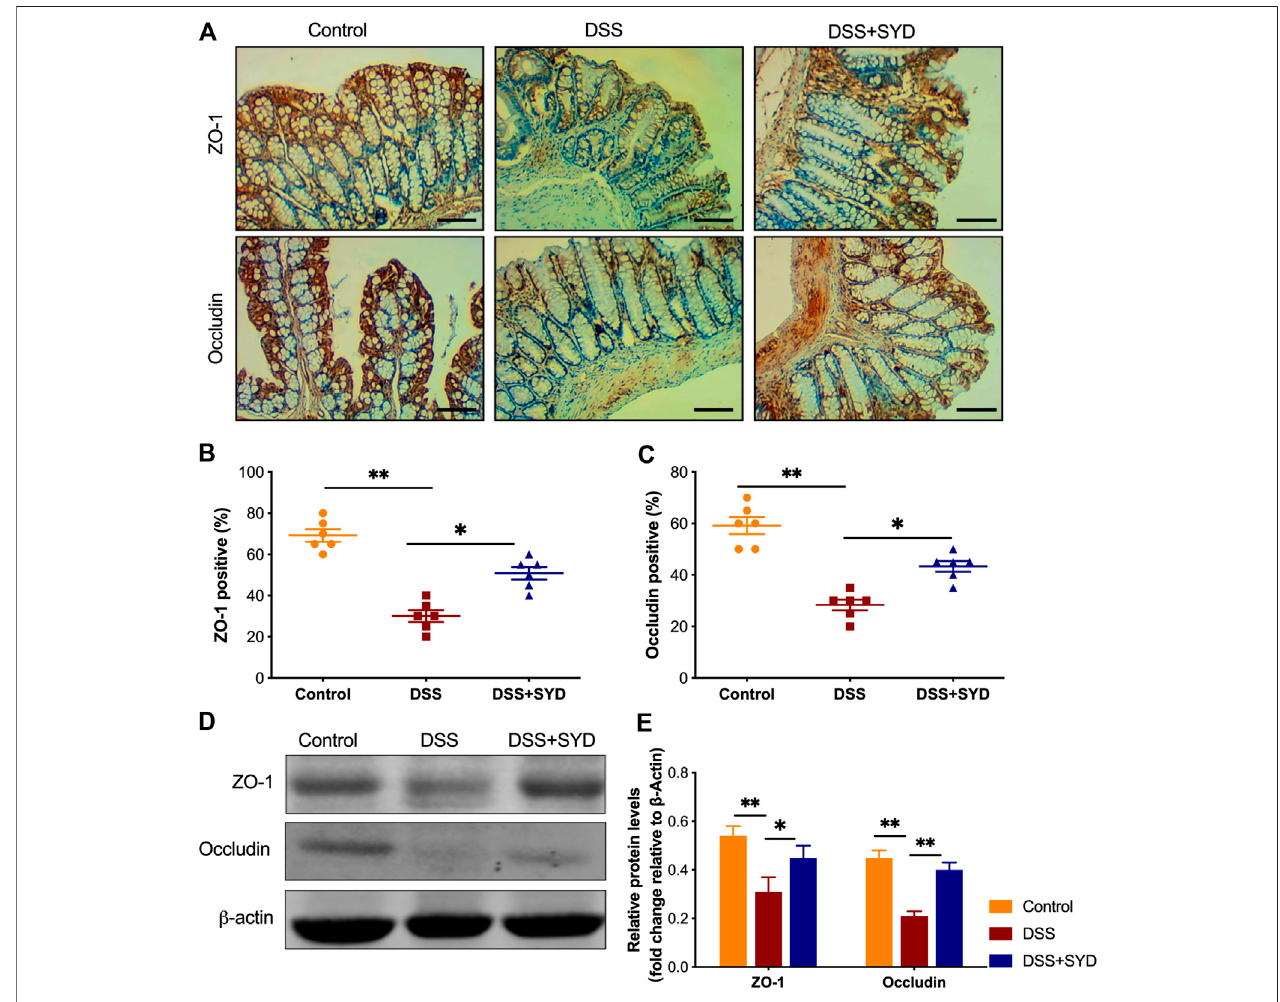
FIGURE7| SYDpromotesintestinalepithelialbarrierfunctioninDSS-inducedcolitismice (A) Immunohistochemicalanalysisoftightjunction(TJ)proteinsZO-1and OccludinincolonsectionsScalebars (cid:2) 100 μ m (B,C) GraphicalrepresentationofthepercentageofZO-1andOccludinpositivecellsinthemid-colon (D,E) Immunoblot analysisoftheexpressionofZO-1andOccludinincolonmucosa.QuantitativeanalysisofZO-1andOccludinnormalizedto β -actin.Eachwesternblotisrepresentativeof three independent experiments. Data are presented as the mean ± SEM, n (cid:2) 6 per group. * p < 0.05, ** p < 0.01.